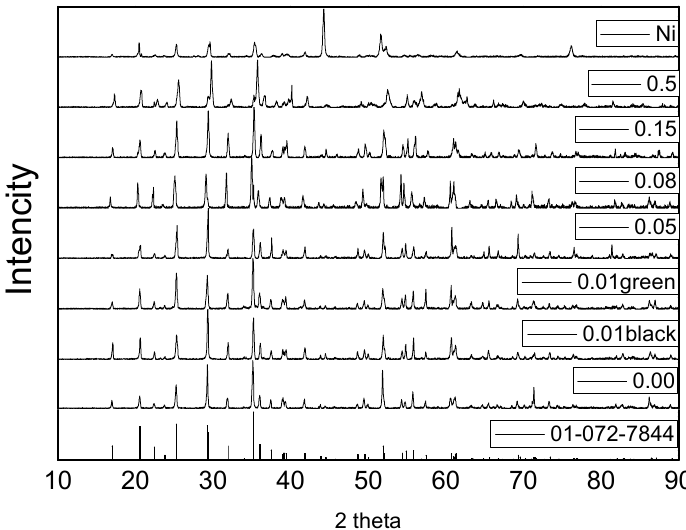
Figure 4. X-ray powder diffraction patterns for Li(Mn 1- x ,Ni x )PO 4 . The crystal structures of the grown crystals were refined by the GSAS program v2.1.